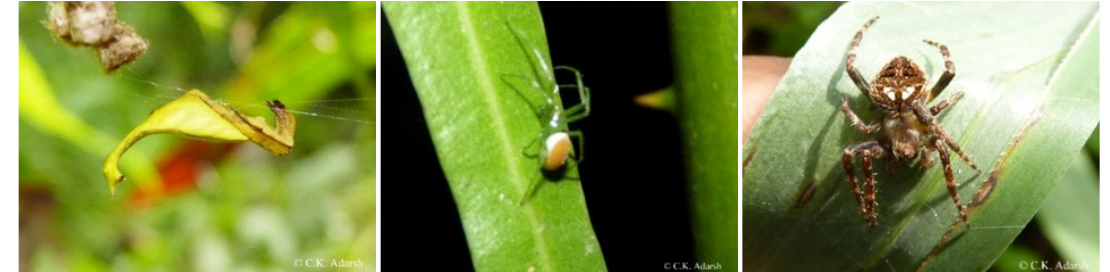
Image 1. Arachnura angura Image 2. Araneus sp.